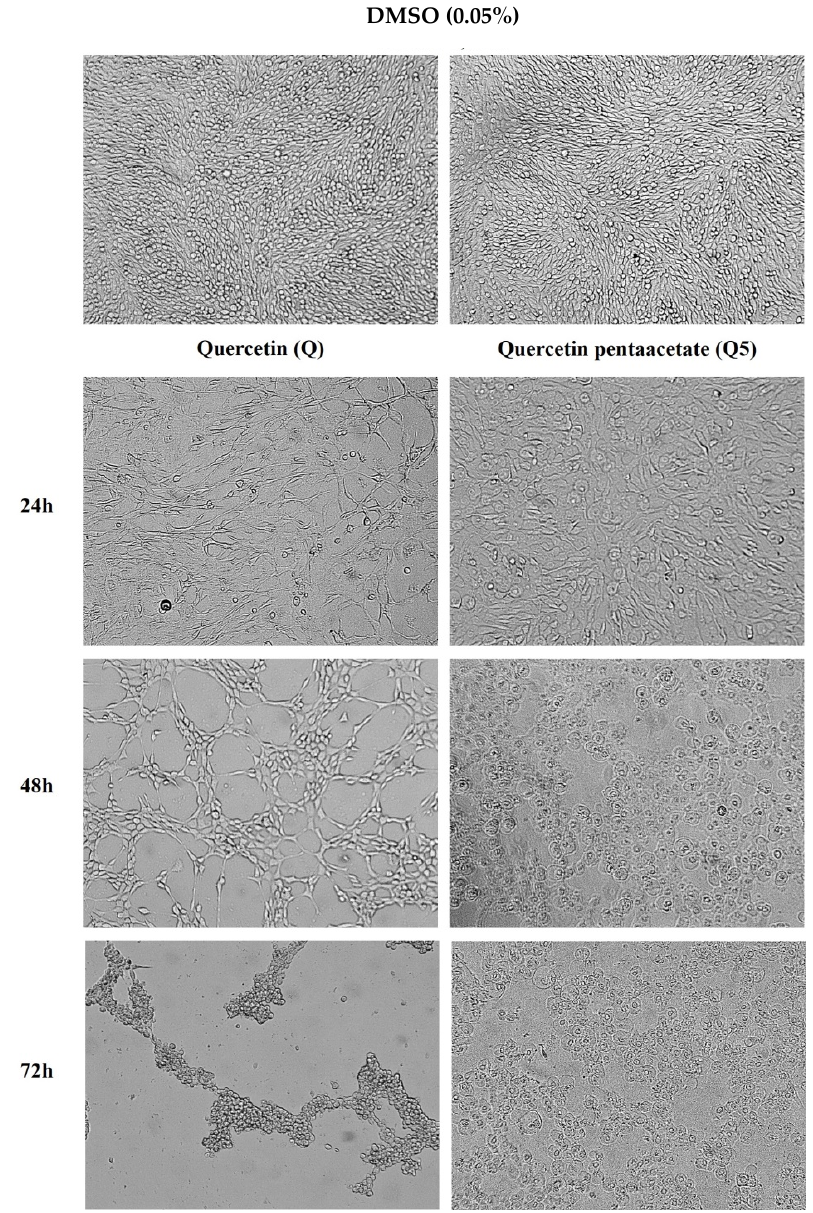
Figure 5. Morphological changes of C6 cells under control conditions (0.05% DMSO), after 24, 48 and 72 h of exposure to 50 μ M of quercetin (Q) or quercetin ‐ pentaacetate (Q50) compounds.